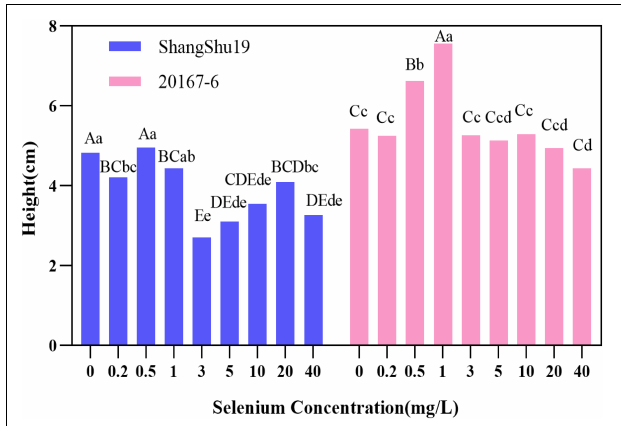
FIGURE 4 | Effects of different selenium concentrations on the plant height of sweet potato. Different lowercase letters in the same category indicated that there were significant differences between Se treatments (Sig < 0.05); Different capital letters in the same category indicated that there were significant differences between Se treatments (Sig <